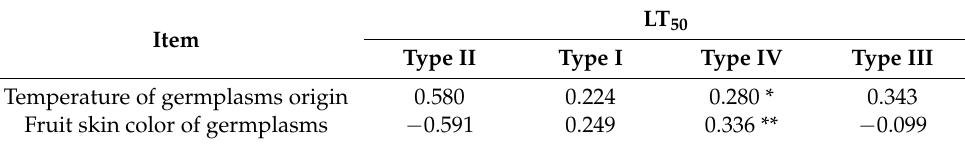
Table 3. Correlation between LT 50 and temperature of germplasm origin and fruit skin